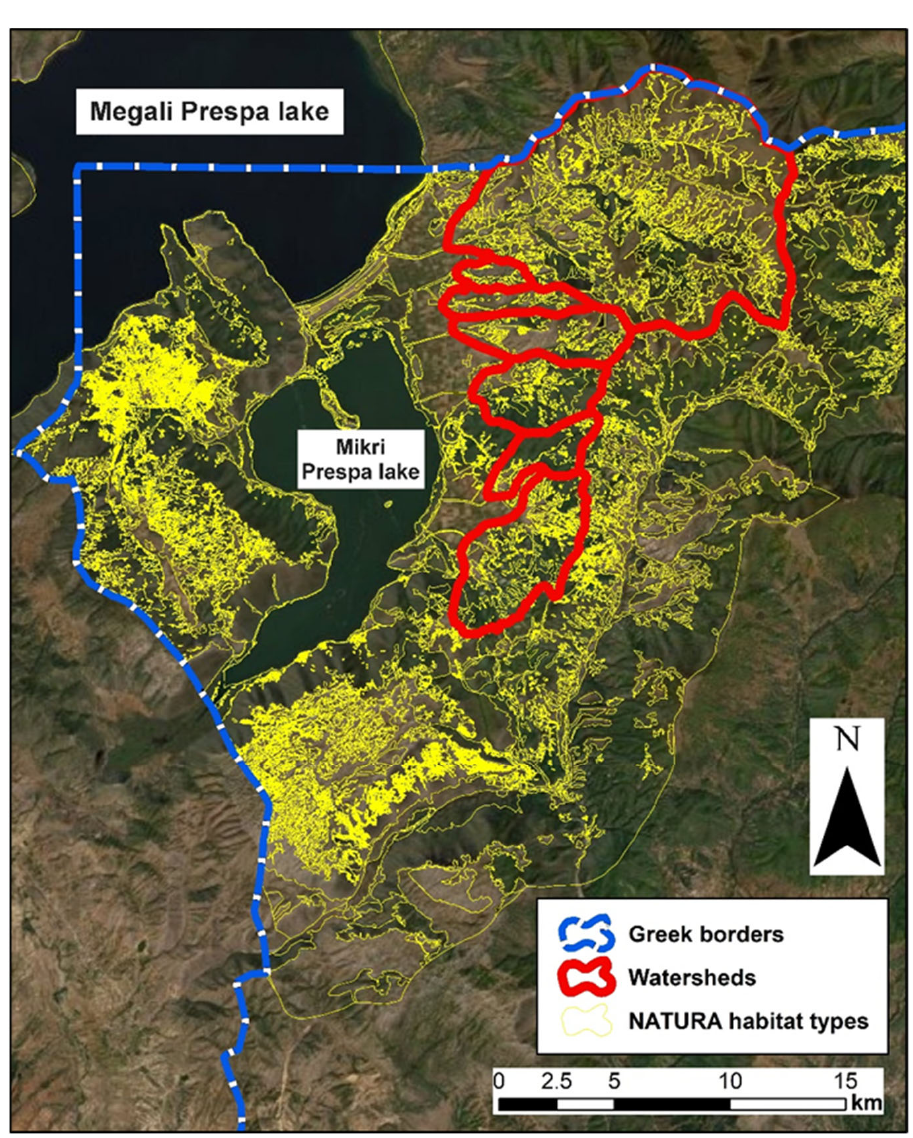
Figure 2. NATURA habitats types in the wider research area. The hydrological modeling was applied in seven (7) typical Mediterranean watersheds, namely Agios Germanos, Mileonas, Platy, Kallithea, Leukonas, Karyes and Mikrolimni (Figure 1). These seven watersheds assigned with the respective settlement names, form the Greek part of the basin of the Prespa Natural Park. The total study area is 104.83 km 2 and the headwaters of the main streams are located to Varnoudas (2334 m a.s.l.) and Moutsaras (2113 m a.s.l.) mountain ranges, the main streams flow generally with a west direction, pass through the above-mentioned settlements and finally flow into Prespa lakes. The relief of the watersheds could be characterized as mountainous and very steep, with an average slope over 42%, but with significant differentiation between the floodplain and the areas above 1000 m a.s.l. In Table 1 the main watershed morphometric characteristics are presented. Table 1. Morphometric characteristics of the watersheds in the study area.